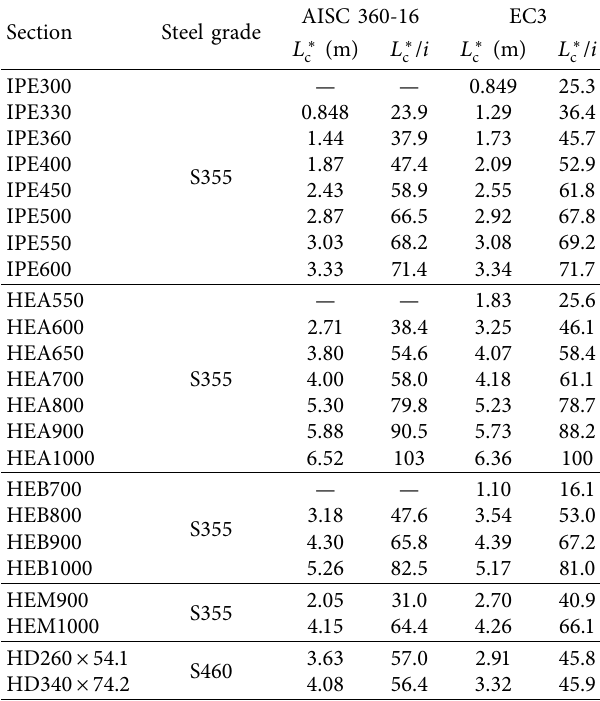
Table 4: The smallest buckling lengths ( L ∗ ) and member slen- c dernesses ( L ∗ / i ) at which the effective cross section of a slender- c element/Class 4 section is equal to its gross area (i.e., A e � A g ). The values listed for EC3 are computed applying the class change allowed in Clause 5.5.1(9) in